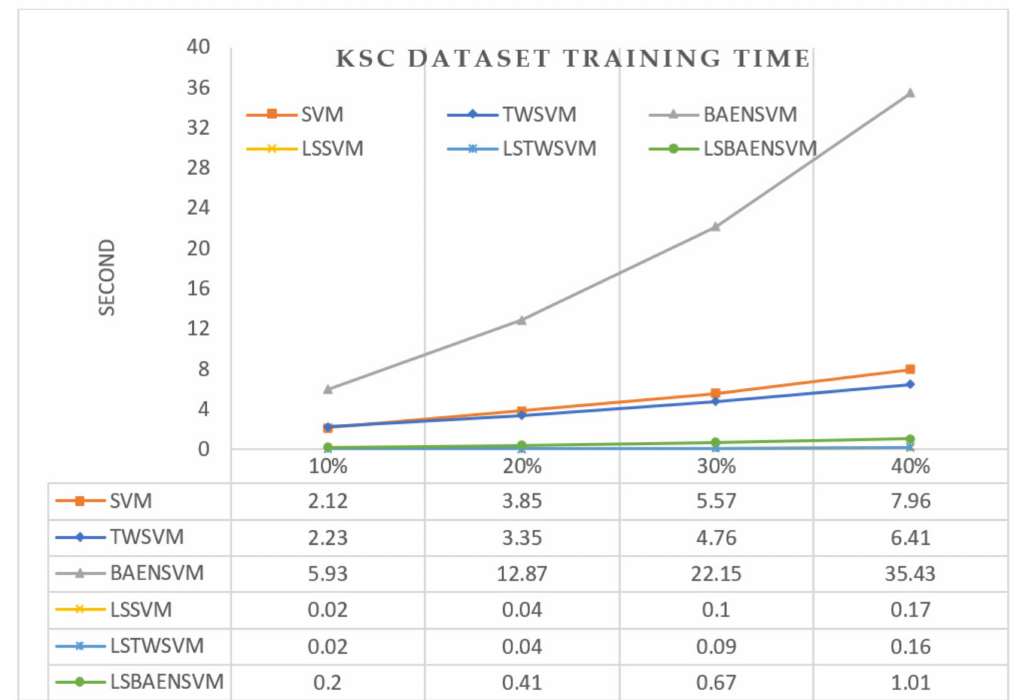
Figure 7. Time-consumption comparison of SVM, TWSVM, BAENSVM, LSSVM, LSTWSVM, and LSBAENSVM using different scales of the Kennedy Space Center training